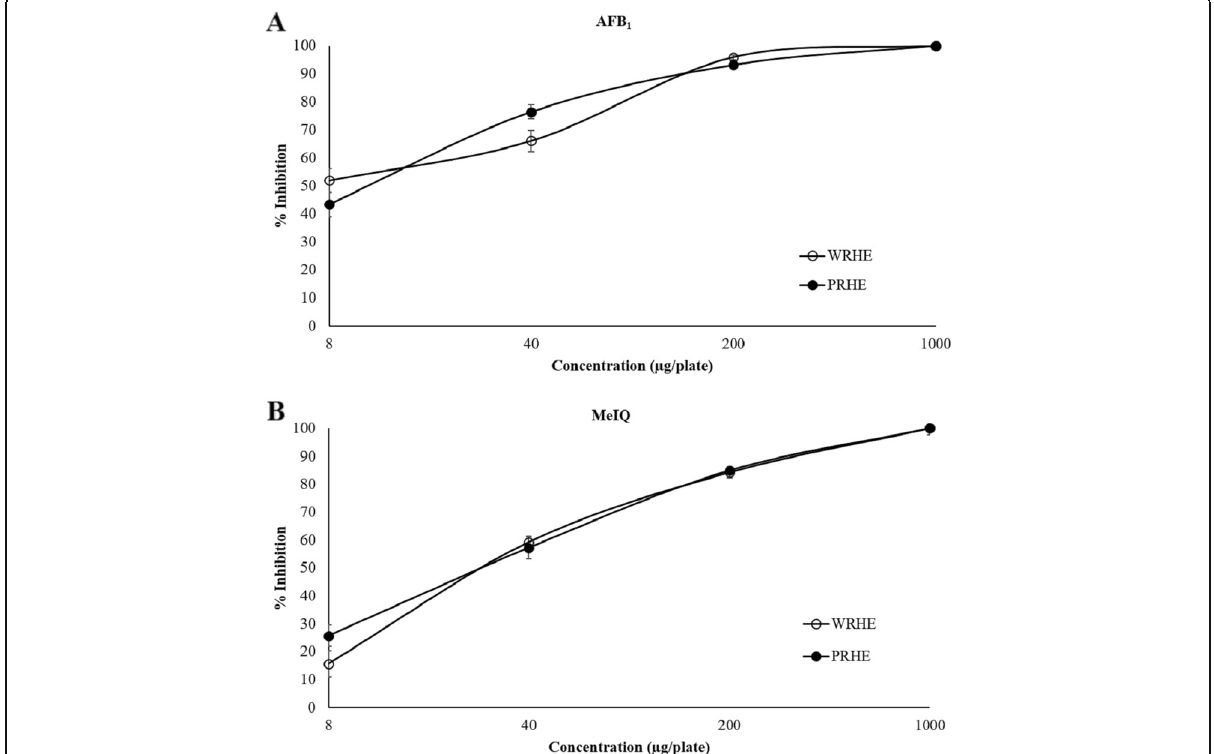
Fig. 2 Antimutagenicity of rice husk extracts against ( a ) aflatoxin B 1 (AFB 1 ) and ( b ) 2-amino-3,4 dimethylimidazo[4,5-f]quinoline (MeIQ) using the Salmonella mutation assay. Values expressed as mean ± SEM. WRHE: white rice husk extract; PRHE: purple rice husk